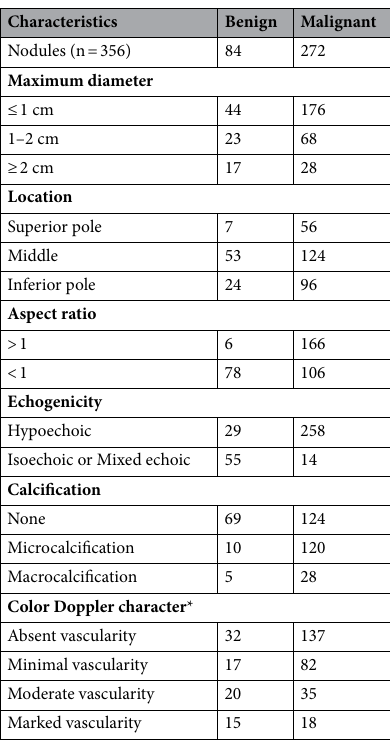
Table 1. Conventional US characteristics of thyroid nodules. *Color Doppler character was graded to be absent, minimal, moderate and marked. Absent vascularity: no vessel; minimal vascularity: point strip blood flow at 1–2 points, and the diameter of vessel was less than 1 mm; moderate vascularity: one vessel which diameter exceeded the radius of the lesion, or 3–4 point strip blood flow; marked vascularity: more than 4 vessels.